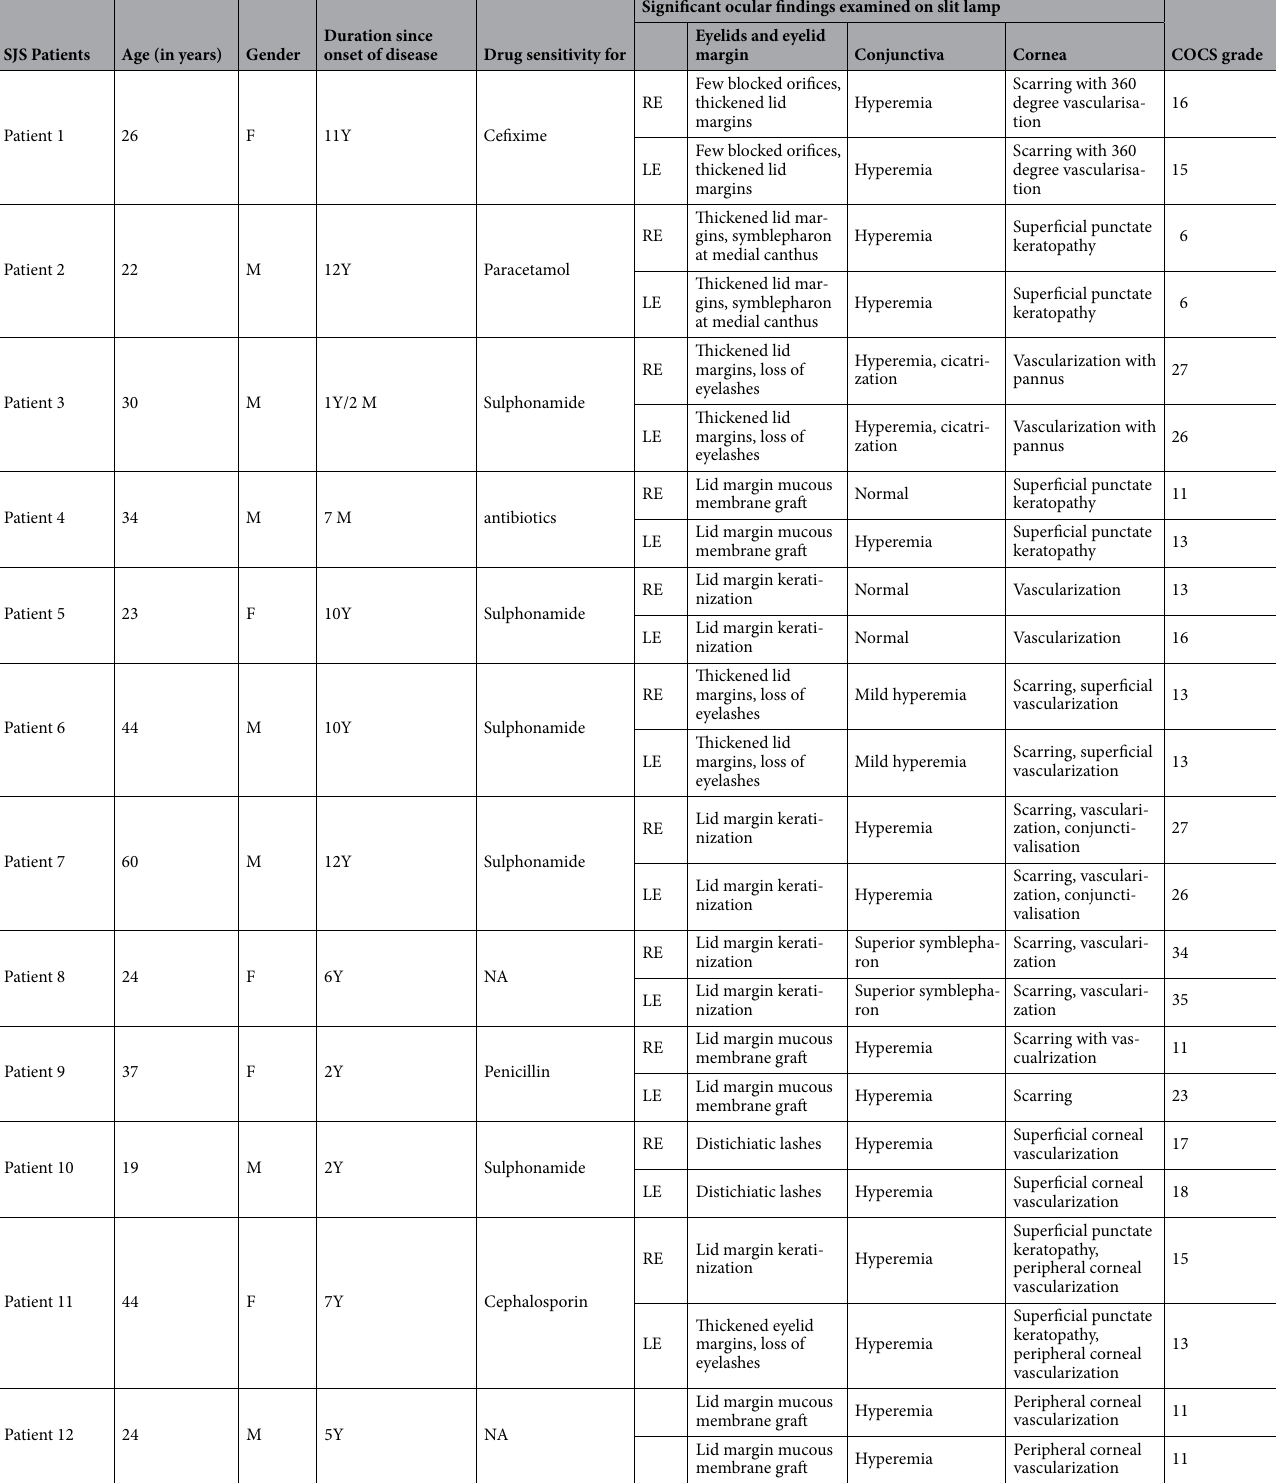
Table 2. Clinical characteristics of patients involved in this study with the slit lamp examinations of each of a patient. In Gender, F female, M male; in duration since onset of disease, Y years, M months; Ocular complications examined on slit lamp, RE right eye and LE left eye, COCS chronic ocular surface complication score [Score as given in Sotozono et al. 26